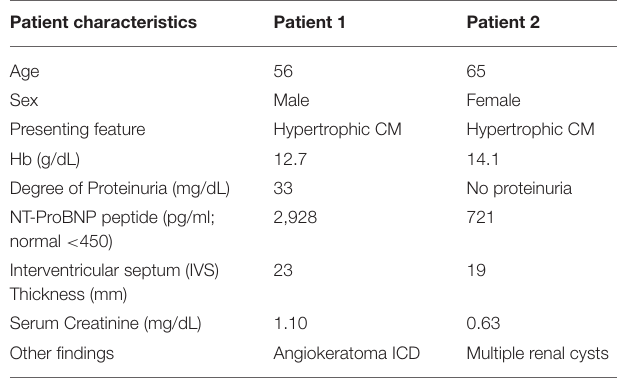
TABLE 1 | Clinical and biochemical findings in the two